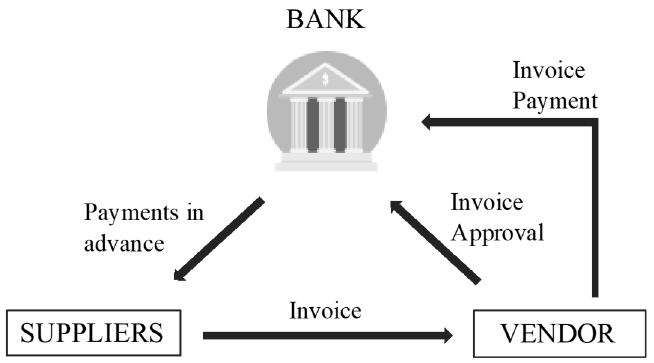
Figure 5. Schematic representation of the reverse factoring mechanism.